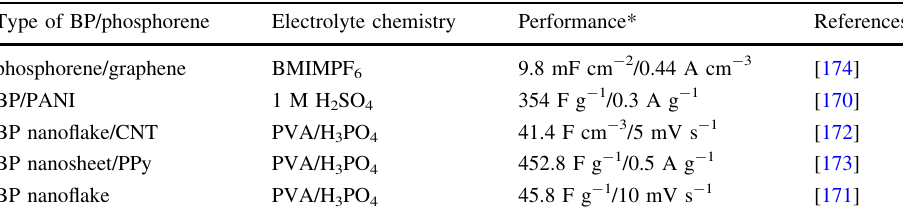
Table 7 Performance of BP/ phosphorene electrodes in various non-Li supercapacitor